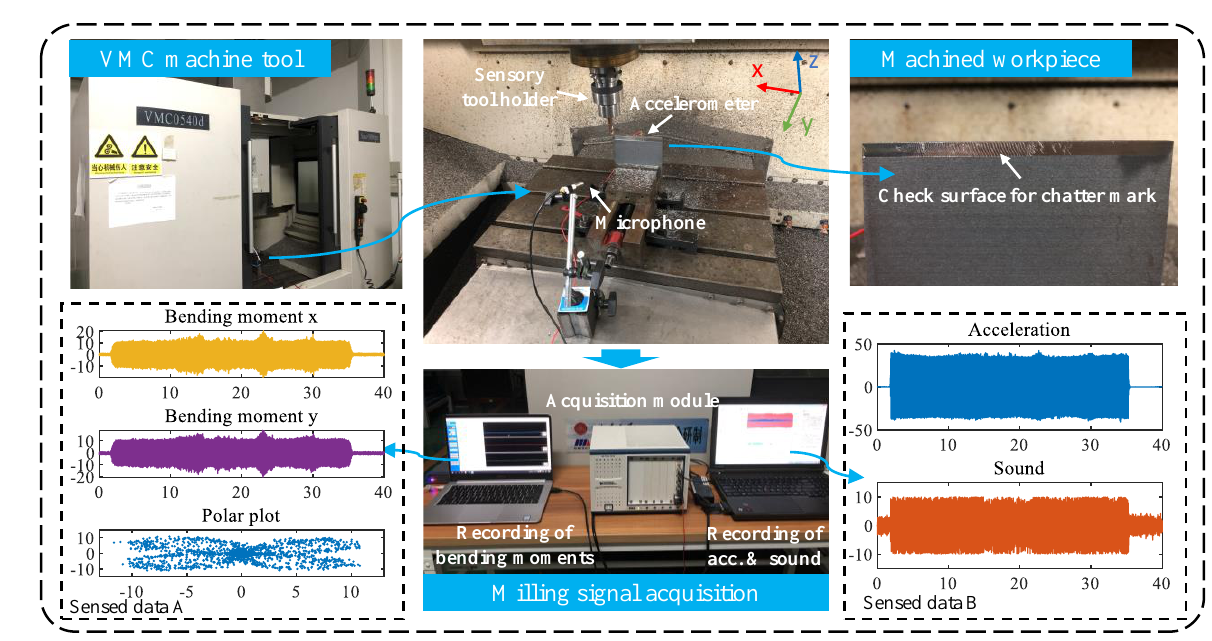
Figure 2. Experimental procedure. Table 1. Process parameters for stable milling condition.